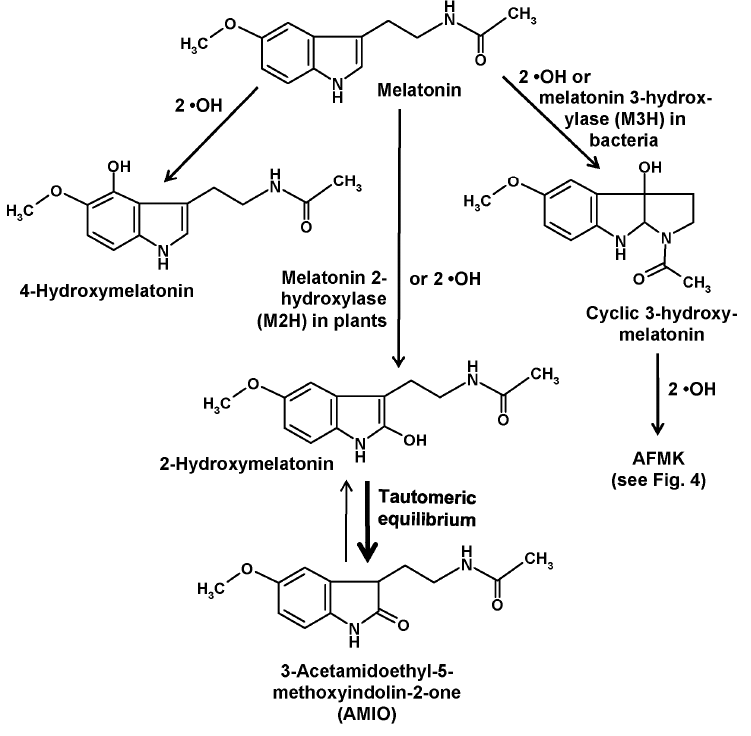
Figure 2. Hydroxylation reactions at ring atoms 2, 3, and 4 of melatonin. Abbreviation: AFMK, N 1 -acetyl- N 2 -formyl-5-methoxykynuramine.